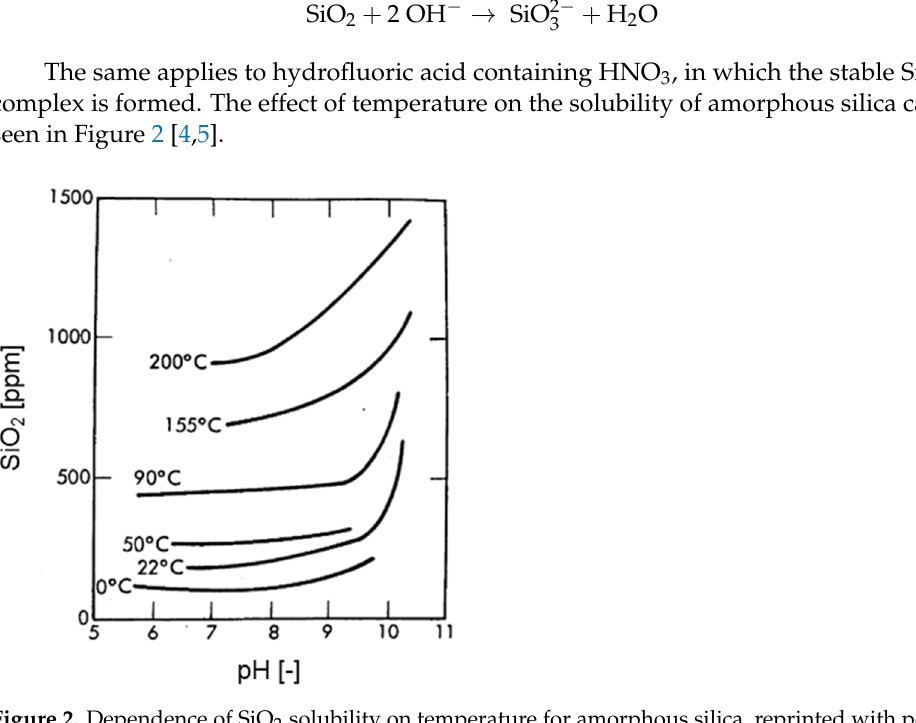
Figure 1. States of silicon with dependence on pressure and temperature, adapted with permission from Ref. [1].